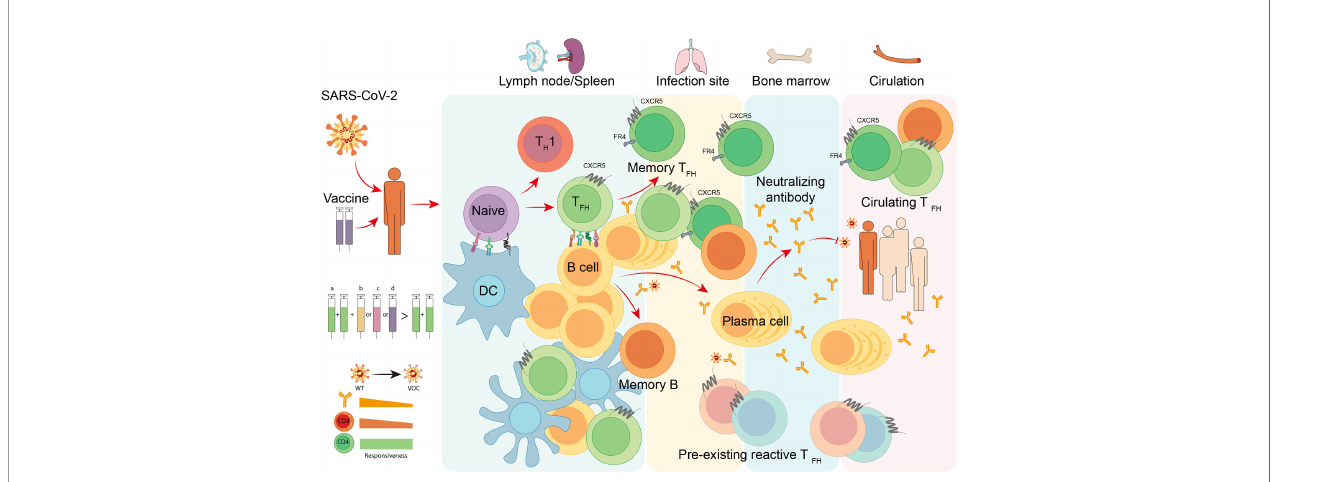
FIGURE 3 | TFH cell responses to COVID-19. Infection or vaccination of SARS-CoV-2 induces differentiation of virus-speci fi c T FH cells and activation of cognate B cells in secondary lymphoid organs like lymph nodes and spleen. With the help of T FH cells, antigen-speci fi c B cells develop into plasma cells to produce neutralizing antibodies with increased af fi nity, and meanwhile, generate long-lived plasma cells and memory B cells that traf fi c to the bone marrow and provide long-term protection. Neutralizing antibodies are capable of blocking the attachment and entry of SARS-CoV-2 to prevent COVID-19. In infection site and circulation, the pre- existing cross-reactive T FH cells and circulating T FH cells are proved to be bene fi cial for the immune protection of natural infection and vaccination. To date, multiple vaccine platforms are utilized to develop SARS-CoV-2 vaccines, including (a) inactivated virus vaccines, (b) adjuvanted recombinant protein vaccines, (c) adenoviral vector-based vaccines, and (d) mRNA vaccines. The heterologous sequential immunization provides a superior effectiveness to protect vaccines from variant of concern (VOC) of SARS-CoV-2 compared to homologous vaccination. The superiority of this vaccination strategy may attribute to the competent responsiveness of memory CD4 + T cells to SARS-CoV-2